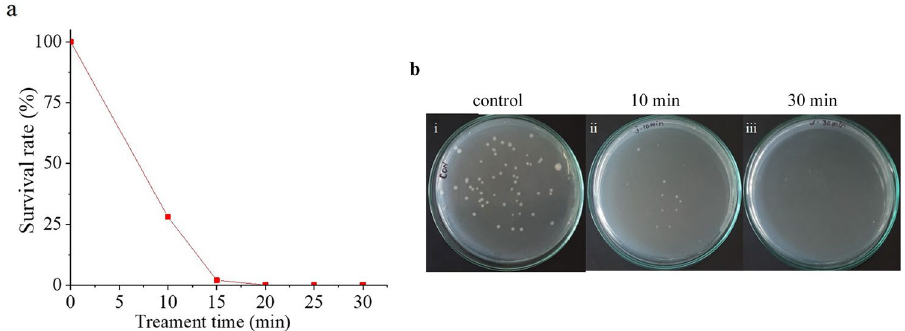
Figure 8. Dynamic water treatment with immersed APPJR ( a ) percentage survival rate of E. coli against treatment time; ( b ) E. coli colony in (i) control plate, and for treatment time (ii) 10 min and (iii) 30 min.